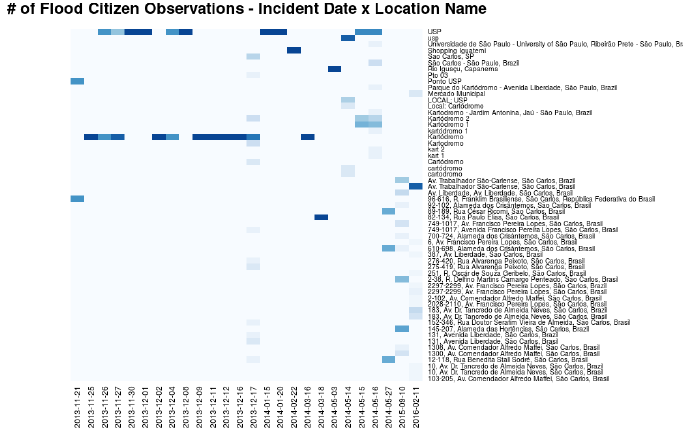
Figure 19. Citizens’ Observations